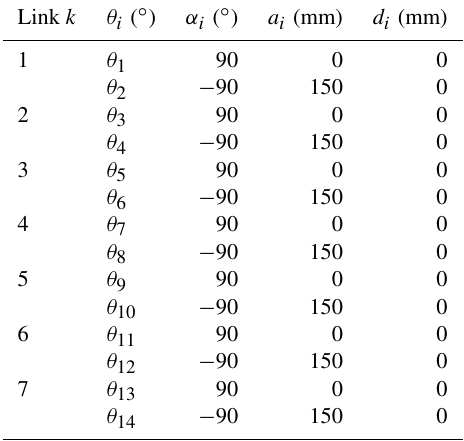
Table 1. D–H parameters of the